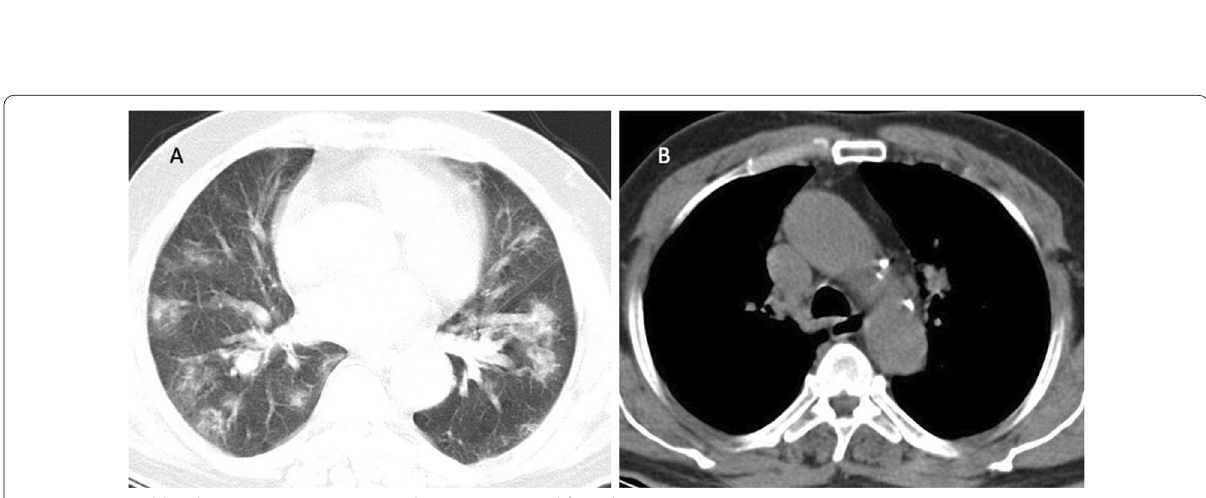
Fig. 3 66-year-old male COVID-19 (